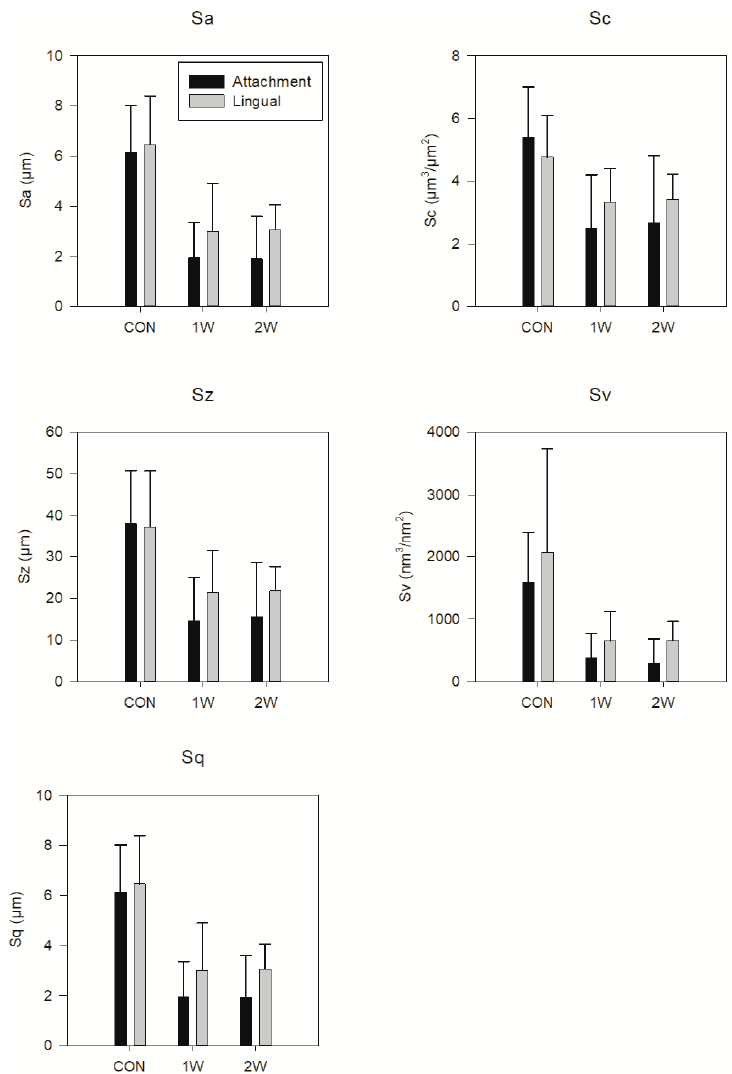
Figure 2. Mean values and standard deviations of all of the roughness parameters tested. Statistical differences are the same for all of the parameters. Statistical differences were significant only between the CON, and 1W and 2W groups for both the lingual and attachment surfaces. Horizontal bars of statistical differences have been omitted for the sake of clarity.